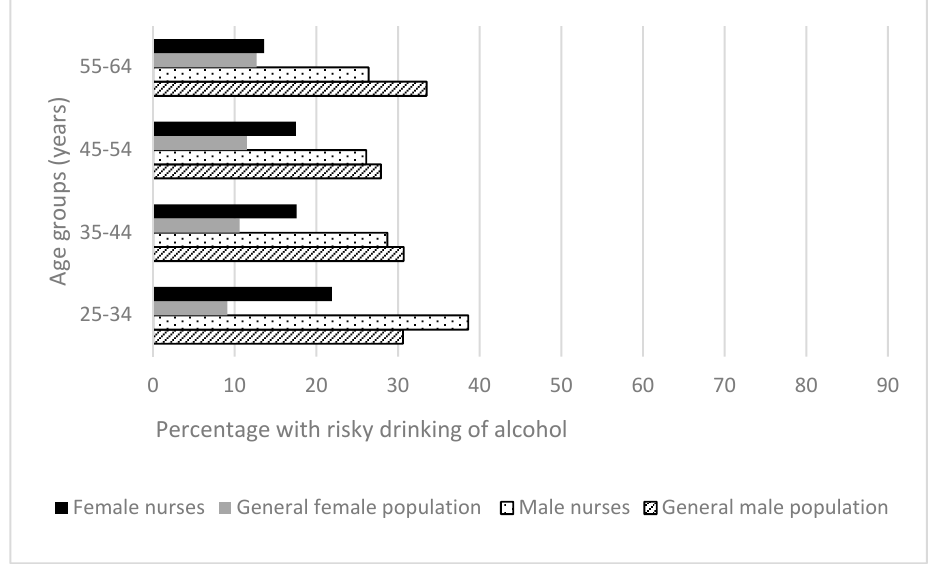
Figure 6. Health-related behaviors of nurses and midwives compared to the Australian general population 2014–2015 [24]: Risky drinking of alcohol.